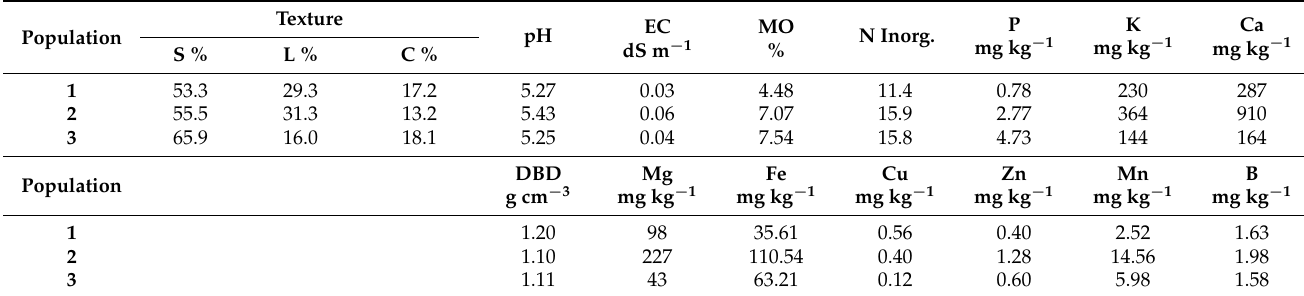
Table 2. The physical and chemical characteristics of soil in three populations of Euphorbia fulgens in the state of Oaxaca, Mexico. 1. San Jer ó nimo Coatl á n. 2. Santiago Jamiltepec. 3. Santa Catarina Juquila *.